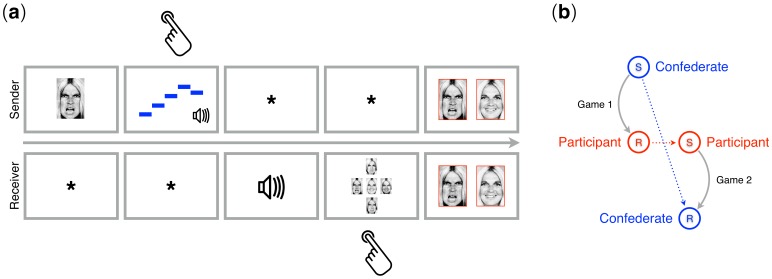
Trial structure and experimental transmission design.(a) Example of a trial from the signaling games played by participants in the second session of the study. The top and bottom rows show what senders and receivers saw on the screen, respectively. For the sender, the task was to compose an isochronous five-tone sequence to be used as a signal for the simple and compound emotions expressed by the image shown on the screen at the start of each trial. For the receiver, the task was to respond to that signal by guessing the image the sender had seen. The sender and the receiver converged over several trials on a shared mapping of signals (tone sequences) to meanings (emotions). Hand symbols indicate when the sender or the receiver had to produce a response. Feedback was provided to both players simultaneously, showing the face seen by the sender and the face selected by the receiver in a green frame (matching faces; correct) or in a red frame (mismatching faces; incorrect). Time flows from left to right. (b) Experimental transmission design in signaling games. The participant played as receiver (R) with a confederate of the experimenters playing as sender (S) in Game 1. Roles switched in Game 2.